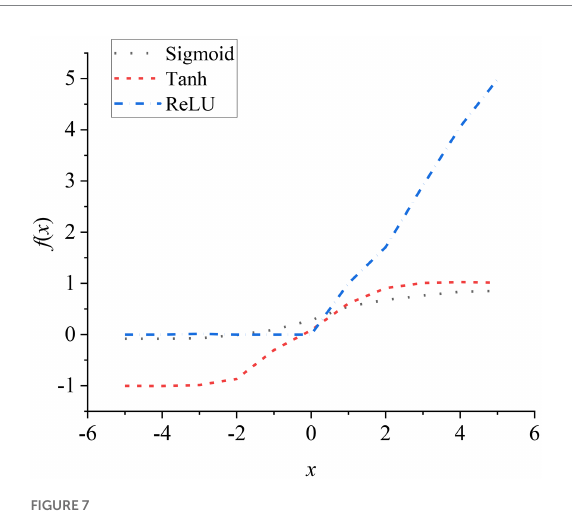
FIGURE 7 Sigmoid, Tanh, and ReLU activation function curves.